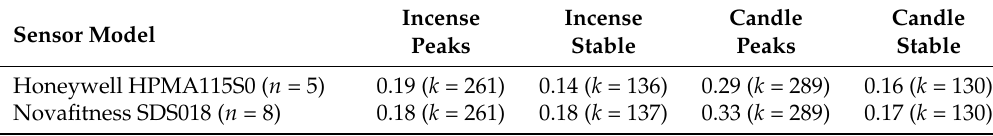
Table A7. Coefficient of variation obtained by the Honeywell HPMA115S0 and the Novafitness SDS018 after correction of their delay for different sources and different variations of PM sources where n is the number of unit of each model used for the calculation and k is the number of data points available.